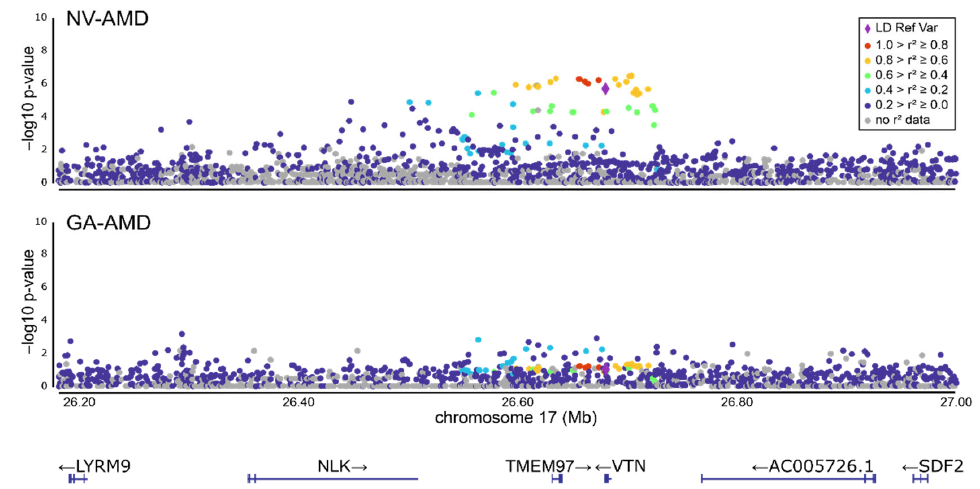
Association of rs704 with AMD subtypes in the IAMDGC dataset. For all associations, the T allele indicates the effect allele. Associations were calculated in comparison with non-AMD individuals (controls). Q-values < 0.05 are indicated in bold.